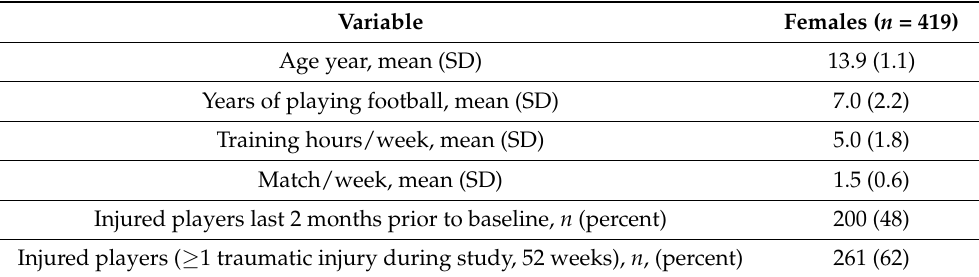
Table 1. The included players’ demographic